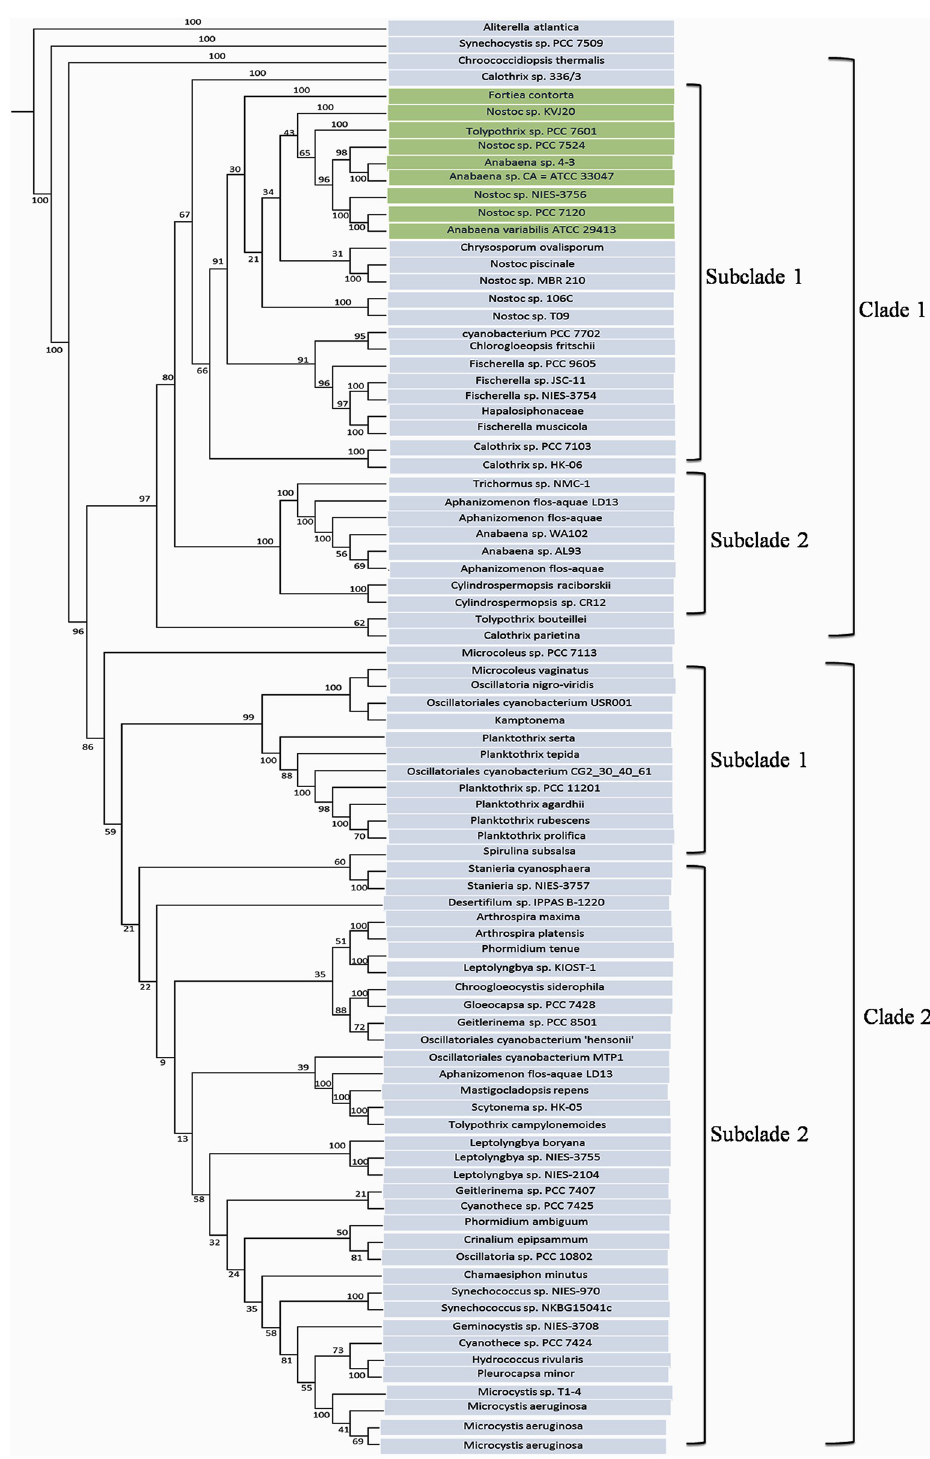
Fig 4. Phylogenetic tree of deduced nrtC protein. The tree was constructed by PHYLIP programs using Seqboot, Protdist, Neighbour and Consense methods. Bootstraping (1000 times) was performed to obtain support values for each branch. Values are shown at the nodes of each branch